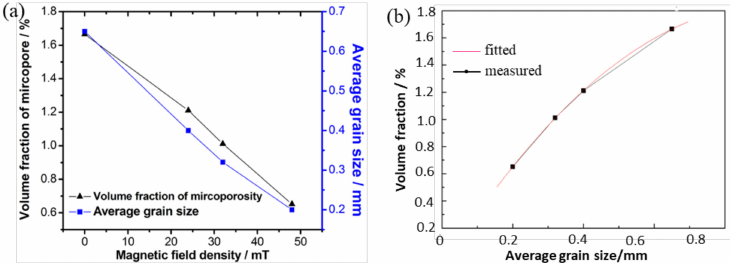
Figure 4. ( a ) The effect of TMF on the micro-pore fraction and grain size in Al-alloy solidified under different magnetic flux conditions; ( b ) result showing the relationship between the volume fraction of the micro-pore and the average primary grain